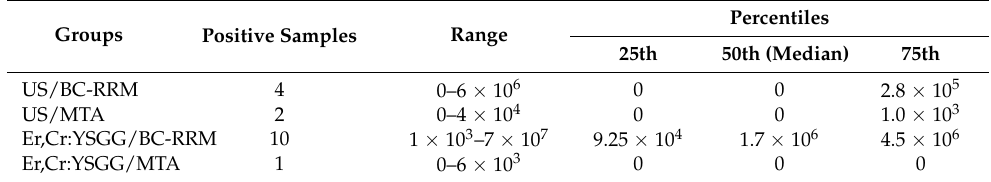
Table 1. Number of E. faecalis CFUs and the number of positive samples in each of the experimental subgroups (n =